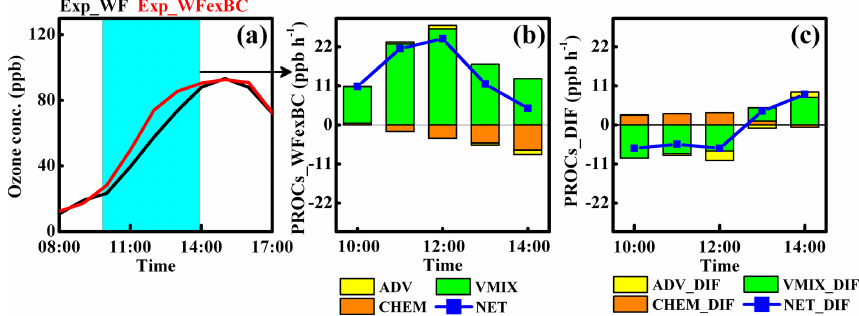
Figure 5. (a) Time series of simulated ozone concentration (unit: ppb) from 08:00 to 17:00LT. (b) Hourly process contributions in the Exp_WFexBC experiment from 10:00 to 14:00LT. (c) Variations in process contributions caused by BC–BL interactions (Exp_WF − Exp_WFexBC) from 10:00 to 14:00LT. Cyan shades in (a) highlight the ozone differences induced by BC. In (b) ADV is advection, VMIX is vertical mixing, and CHEM is chemistry, and the blue line with squares denotes the net value of the processes (NET). In